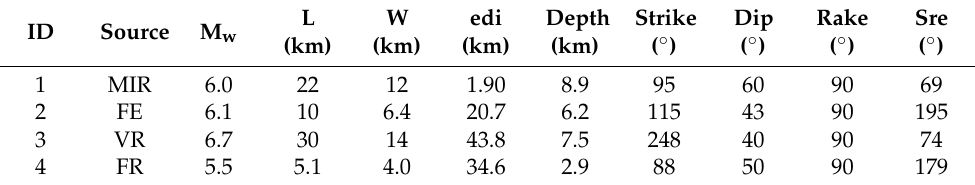
Table 2. Some characteristics of the four selected seismogenic sources [40,44]. The acronyms are related to: edi = epicentral distance; depth = focal depth of the earthquake occurred; strike = defines the orientation of the fault counter-clockwise till the North; dip = represents the inclination of the fault plane; rake = the direction the hanging wall moves during rupture measured relative to the fault strike; sre = represents the angle formed between the focal point and the